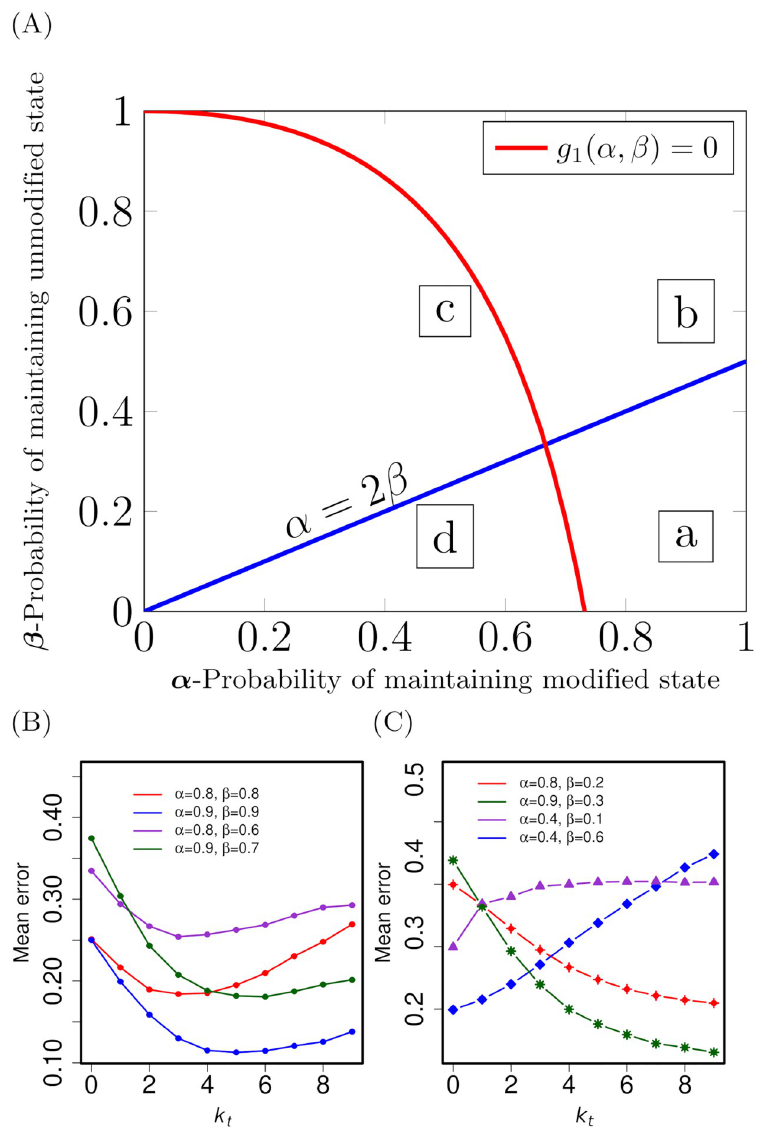
Fig 4. Behavior of our algorithms across the parameter spaces (A) Four ( a , b , c , d ) regions in ( α , β ) parameter space. The curves shown are g 1 ( α , β ) = 0, and α − 2 β = 0. In region a ( g 1 > 0, α > 2 β ), the SMAP will replace every 0 with 1. In the region b ( g 1 > 0, α < 2 β ), enzymes can implement threshold- k filling (see text). This parameter regime is realistic, biologically. Region c has small values of α and relatively higher values of β . As per the SMAP algorithm, this region will not be filled with 1s. In region d , where α is very high compared to β , there is intermediate filling of 1s in the daughter sequence. (B) The mean error ( � D ) when we fill all islands of 0s having size at most k t . All these curves have ( α , β ) values in region b , and � D is non-monotonic having a finite optimum k t = k � . (C) � D for parameter values in region a (red and green curves) are monotonically decreasing suggesting that the optimal k t is unbounded; hence the least error would be when all 0s are replaced with 1s. In regimes c , d (blue and violet curves) the mean error is minimal when nothing is filled suggesting that threshold- k filling is not suitable here. The standard errors here are smaller than the size of the